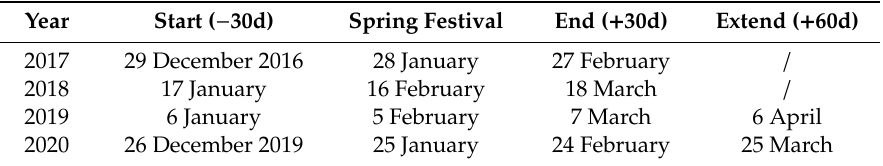
Table 1. Study period for